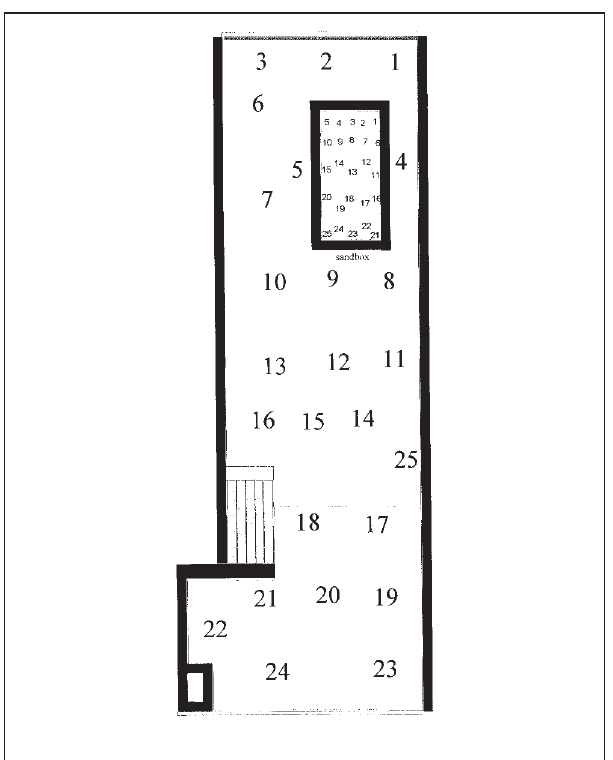
Figure1) Divisionofsandboxandplayareainto25areasforsampling